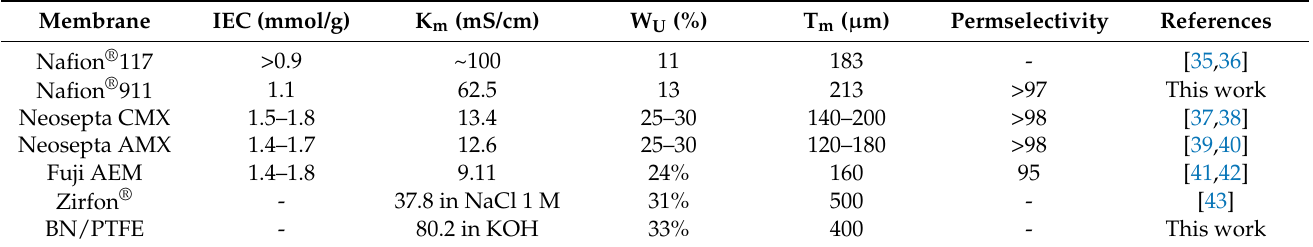
Table 1. Main characteristics of the used ion-exchange membranes in the electrolysis cell.